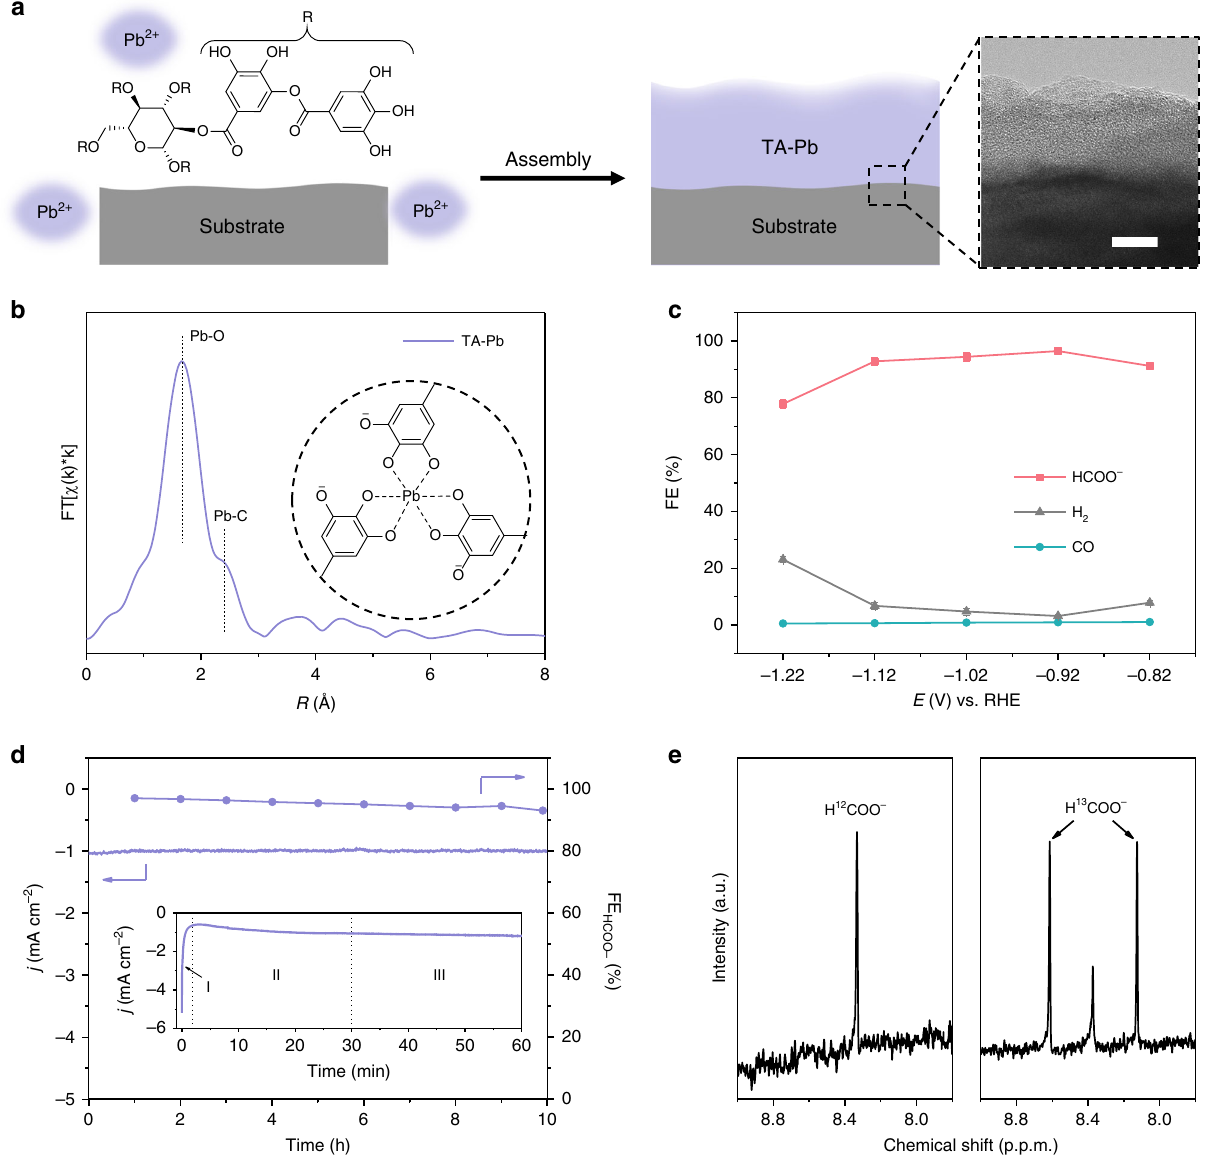
Fig. 1 Preparation, characterizations and electrochemical performances of TA – Pb. a A scheme illustrated for the TA – Pb preparation. The inset is the HRTEM image of single-layer TA – Pb. Scale bar, 10 nm. b Pb L 3 -edge EXAFS spectrum of TA – Pb. The inset is the proposed structure of TA – Pb. c FEs of 3-layer TA – Pb at steady state under different potentials. d j-t curve and corresponding formate FE of 3-layer TA – Pb at steady state (stage III in the inset) under − 0.92 V. The inset is the j-t curve of the as-prepared TA – Pb, which can be divided into three stages labeled as I, II, and III. e 1 H-NMR spectra of formate by using 12 CO 2 and 13 CO 2 as feedstocks by using 0.5 M Na 2 SO 4 as the electrolyte to eliminate the interference of NaHCO 3 . Error bars correspond to the standard error of the